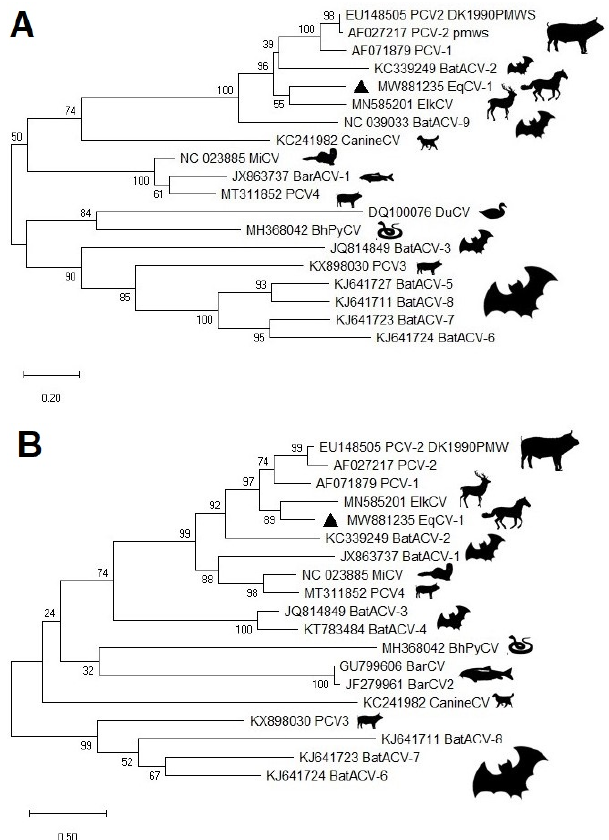
Figure 2. ( A ). Phylogenetic analysis of EqCV1-Charaf replicase. ( B ). Phylogenetic analysis of EqCV1-Charaf capsid. The scale indicates amino acid substitutions per position. The amino acid (aa) pairwise alignments were performed with Genious software using the in-built MAFFT algo- rithm. The phylogenetic trees were constructed using the Maximum likelihood method with sub- stitution model: Le Gascuel 2008 based model with gamma-distributed (G+) for Rep and Cap in MEGA software version X [33,41]. According to the ICTV, the member of the same circovirus species should share >80% nucleotide identity over their entire genome, and >70% amino acid identity be- tween their Cap proteins [1]. When using the complete genome the closest relative to EqCV1-Charaf was elk circovirus with 74.4% identity over 58% of genome. Its closest capsid protein, also from elk circovirus, was only 63% identical. EqCV1 is therefore proposed as a new species in the genus Circovirus, and the first circovirus species found in a member of the Equus genus.